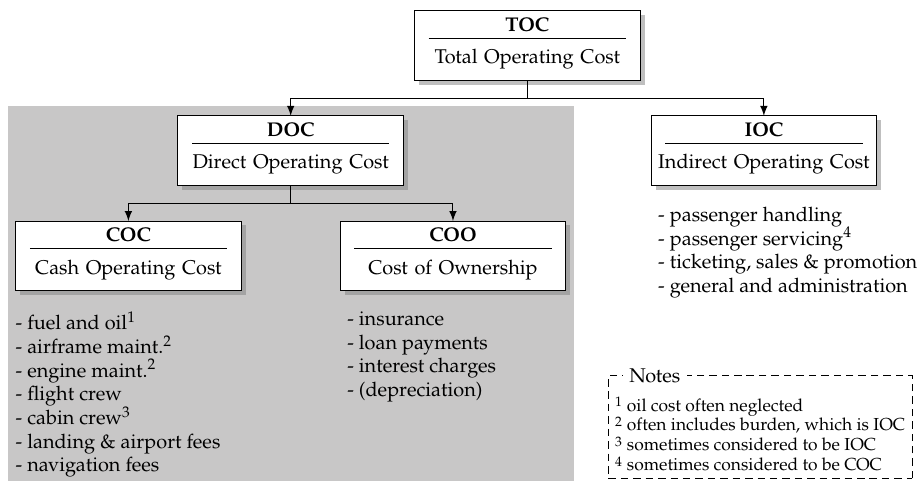
Figure 2. Typical Airline TOC breakdown, based on Clark